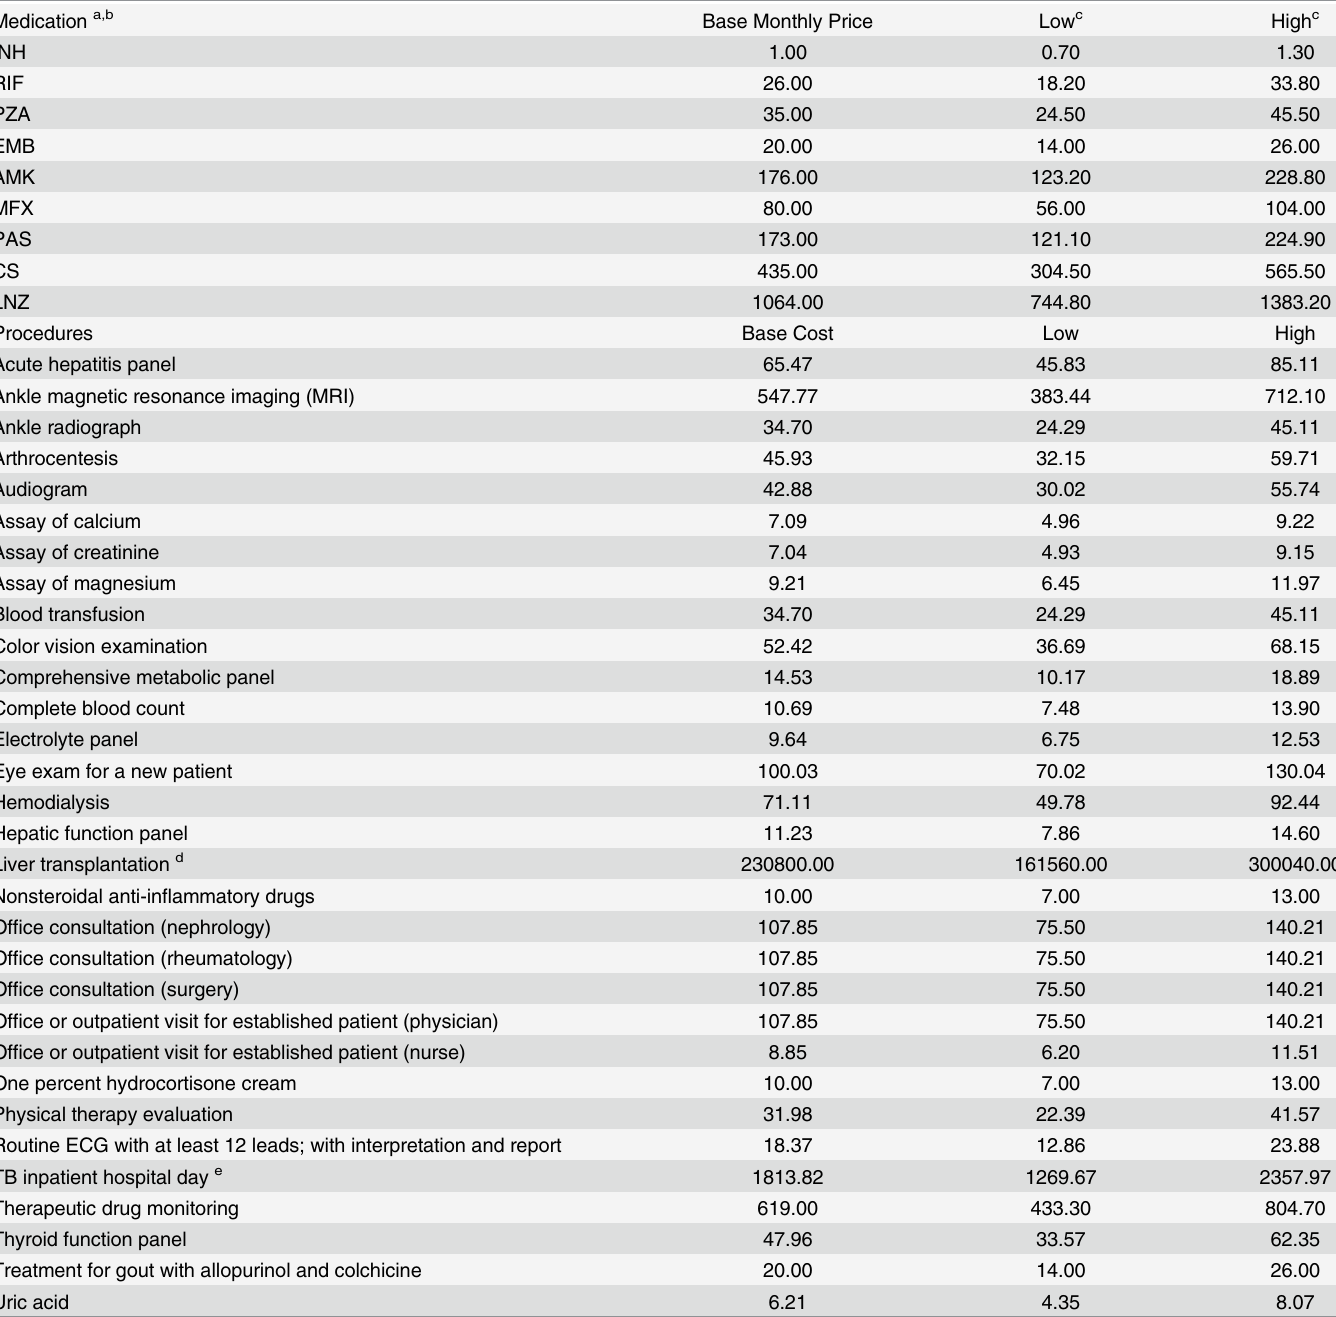
Table 3. Costs and ranges of medications, procedures and medical tests due to medication adverse event in US dollars,